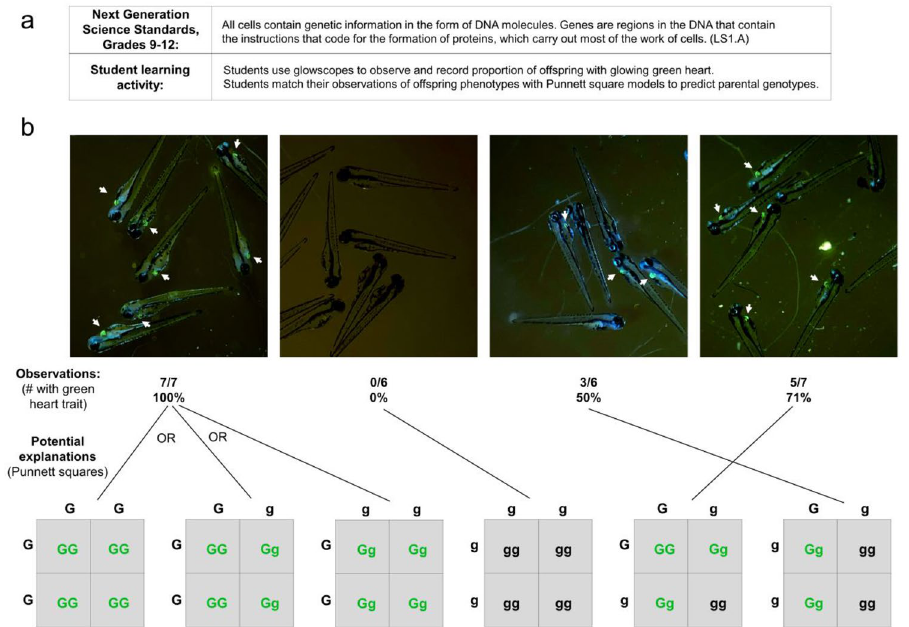
Figure 8. Grades 9–12 NGSS student learning activity focused on genetics and inheritance. ( a ) Description of NGSS standard and proposed student activity. ( b ) Representative glowscope fluorescence images of 4 dpf Tg(myl7:EGFP) zebrafish larvae used to determine the proportion inheriting the green heart trait (indicated by white arrows). Tabulated data, each set obtained from a single clutch of zebrafish embryos, are matched to Punnett squares that are consistent with the observed offspring phenotypic ratios. Images were acquired using an Apple iPhone 12